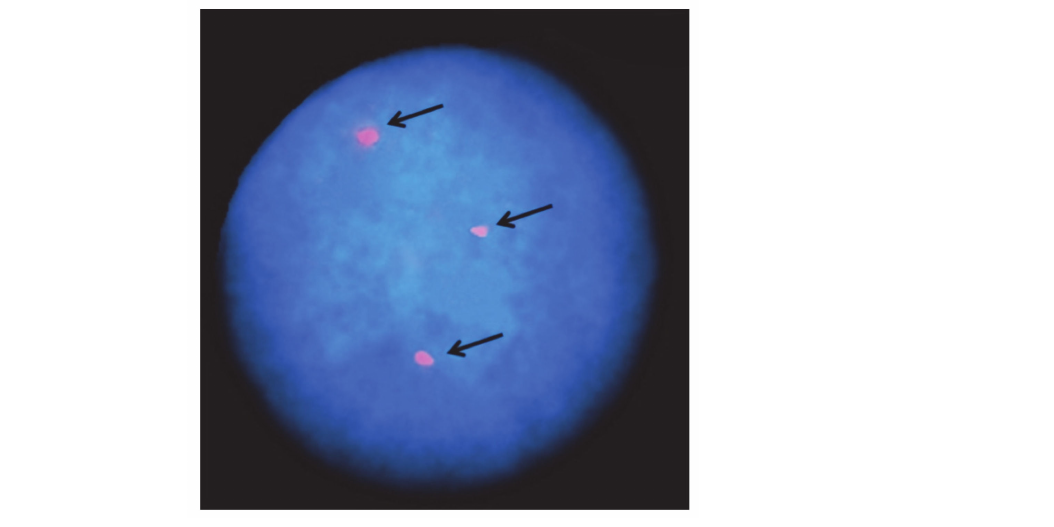
Figure 1. Interphase nucleus of a female cattle calf affected by trisomy 28. Arrows indicate the three FITC signals of the BAC clone containing the conglutinin (CGN1) gene, the official marker of BTA28 (ISCNDB2000,